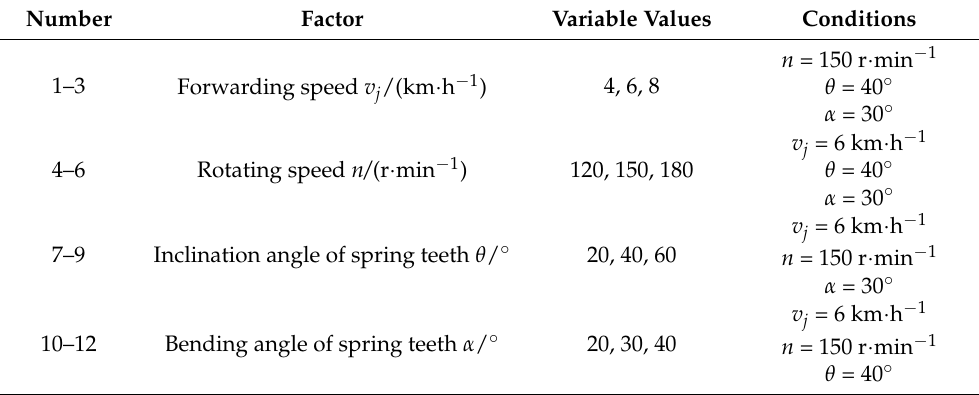
Table 3. Single-factor simulation